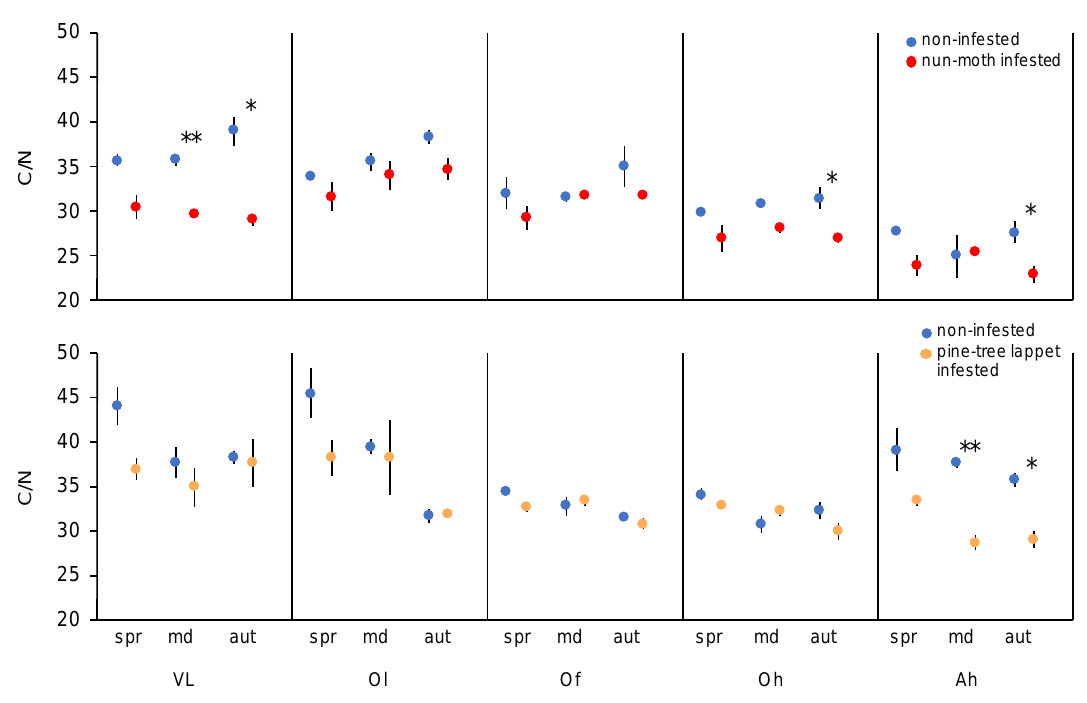
Figure 1. The mean ± standard error of the C/N of the vegetation layers, organic layers, and the mineral soil of the nun moth ( Lymantria monacha L.) and pine tree lappet ( Dendrolimus pini L.) infested and non-infested Scots pine ( Pinus sylvestris L.) forest site. VL = vegetation layer, Ol = litter organic, Of = fibric organic, Oh = humic organic, Ah = humic mineral, spr = spring, md = main defoliation, aut = autumn, n = 9, the asterisks indicate significant differences between the infested and non-infested sites at same date and layer based on pairwise Student’s t-test, ** p < 0.010, * p < 0.050.